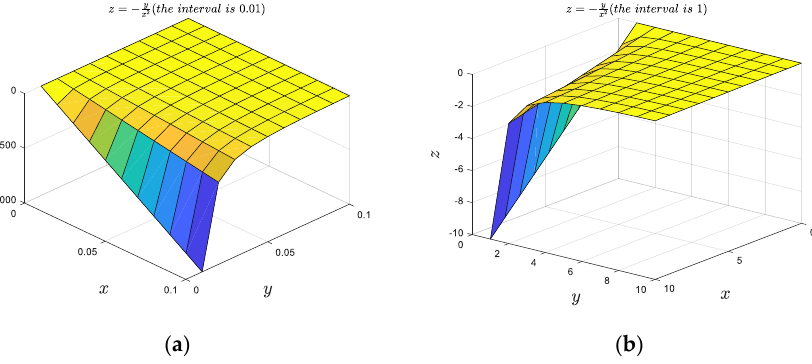
Figure 2. ( a ) The type 1 function selects a three-dimensional image calculated at every 0.01 step size; ( b ) the type 1 function selects a three-dimensional image calculated at every 1 step size.